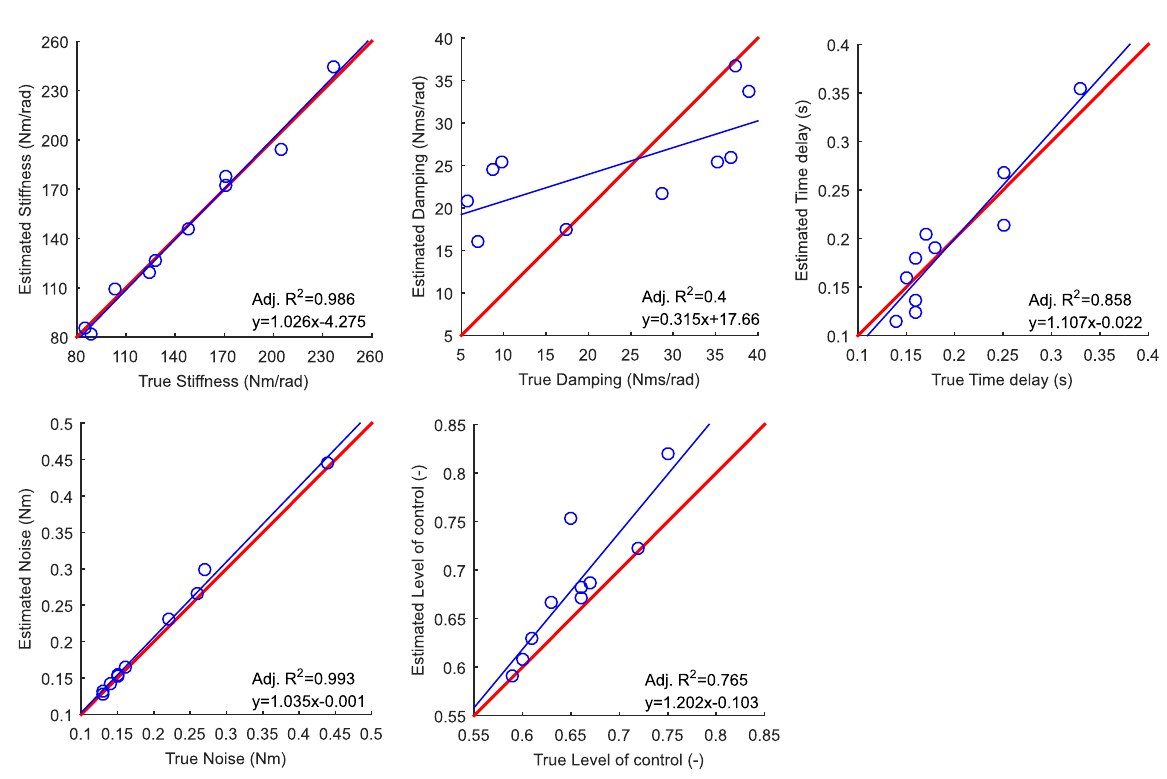
Figure 5. Estimated parameters (posterior mean values) against true parameters. The equation for the estimated parameters against the true parameters is presented with a blue thin line. The equation should ideally be y = x , as indicated with a red thick line. The corresponding adjusted R 2 values are shown in the